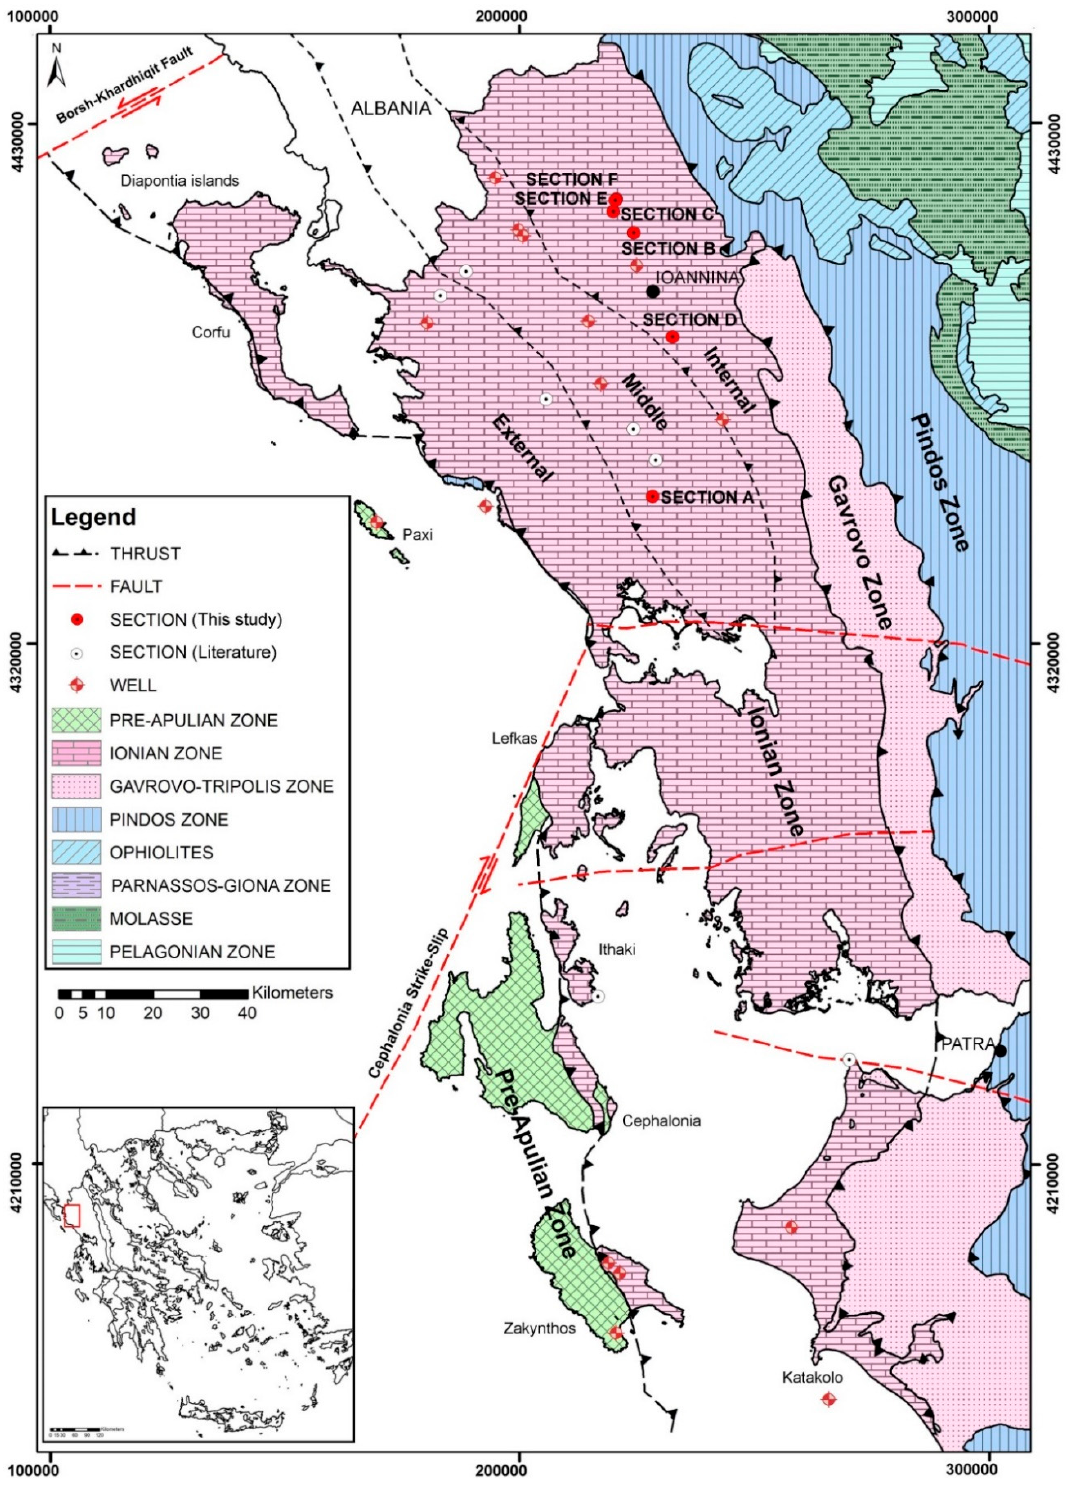
Figure 1. Geological map of the external Hellenides in NW Greece (modified from [34,35]) illustrating the principal tectonostratigraphic zones: Pre-Apulian, Ionian, Gavrovo, Pindos. The red box shows the study area, the northwestern part of the Epirus region, where the separation of Ionian zone to external, middle, and internal sub-basins along with the regional locations of the study sections to be also indicated. Legend interpretations are presented in the inset.